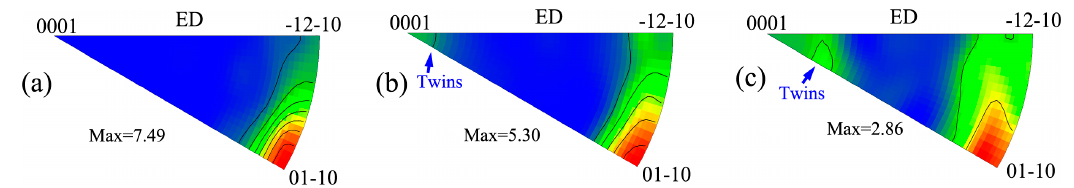
Figure 5. Inverse pole figures of ( a ) SS; ( b ) center position of ST and ( c ) edge position of ST.